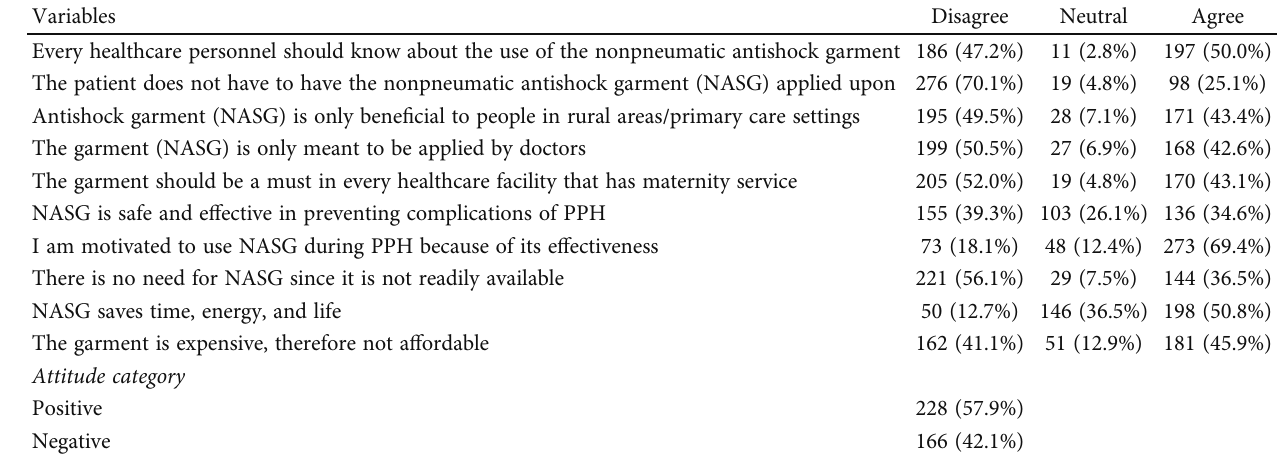
Table 4: Attitude of respondents who participated in the study and were working in public hospitals of Sidama region, Ethiopia, 2022 ( N = 394